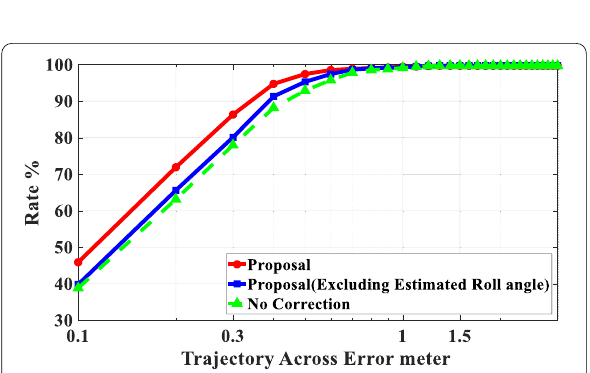
Fig. 21 Evaluation of vehicle trajectory (Urban